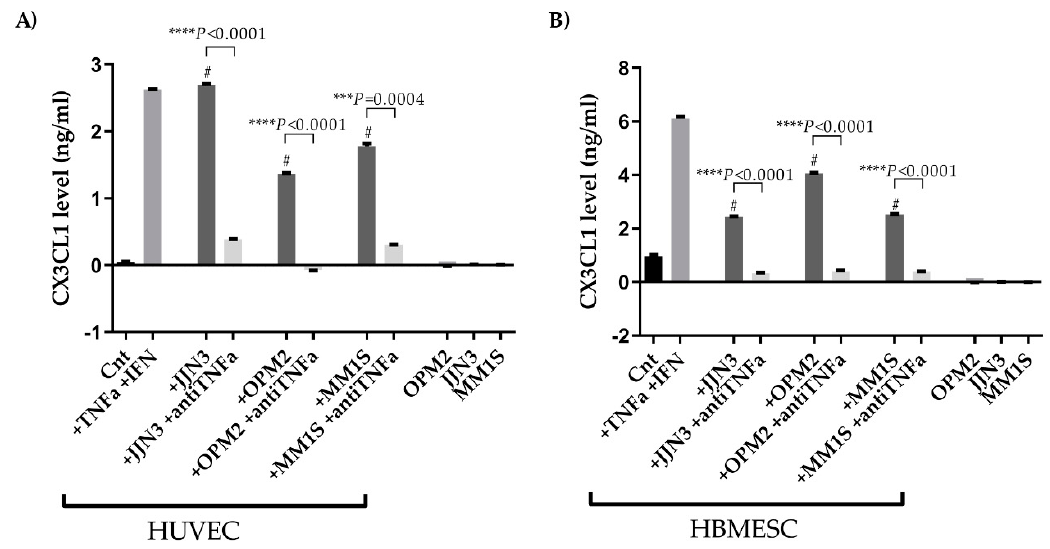
Figure 4. MM cells increase the angiogenic activity of ECs through CX3CL1 production. HUVEC ( A ) and HBMESC ( B ) were treated for 24 h with TNF α (50 ng/ml) and IFN γ (10 ng/ml), as positive control,